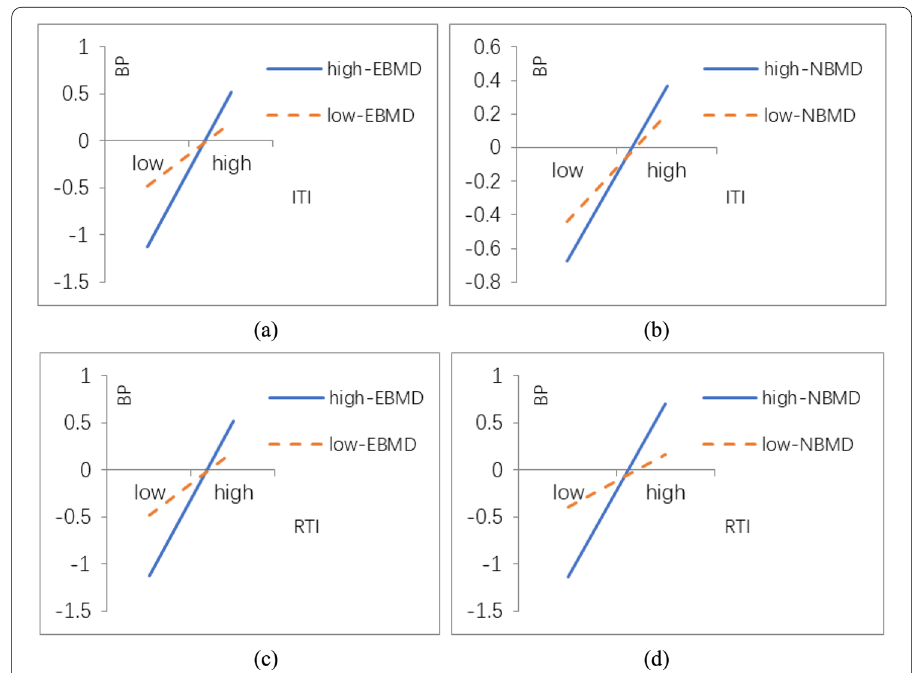
Fig. 2 Business model design regulates the impact of technological innovation on corporate